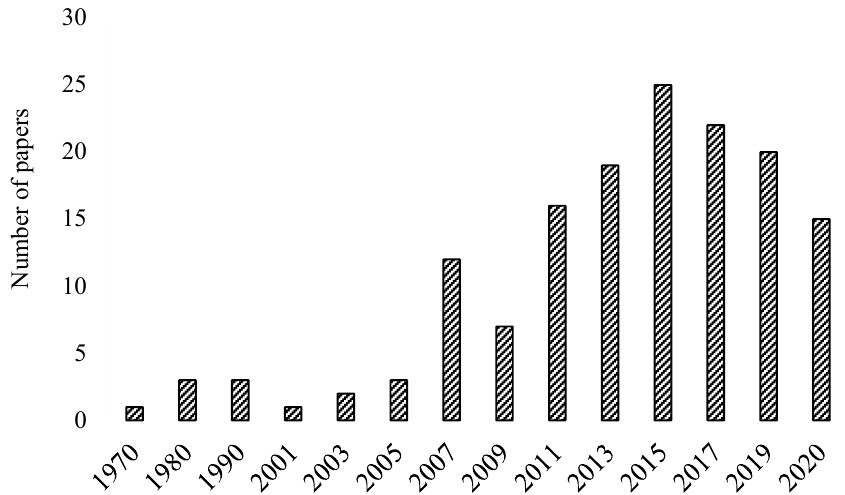
Figure 1. Papers analyzed critically in this review paper published in the different time regimes.